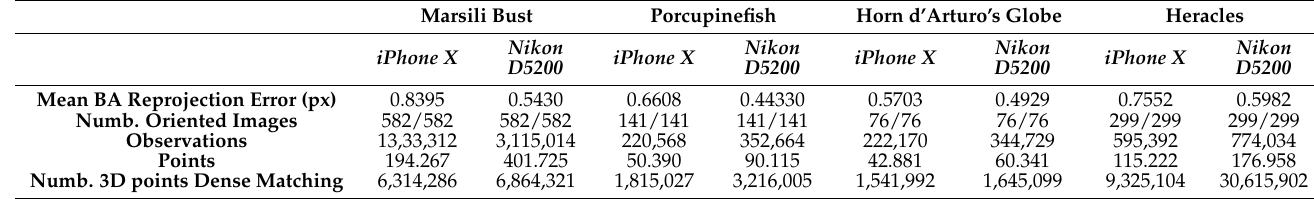
Table 10. iPhone X vs. Nikon D5200 photogrammetric process results.